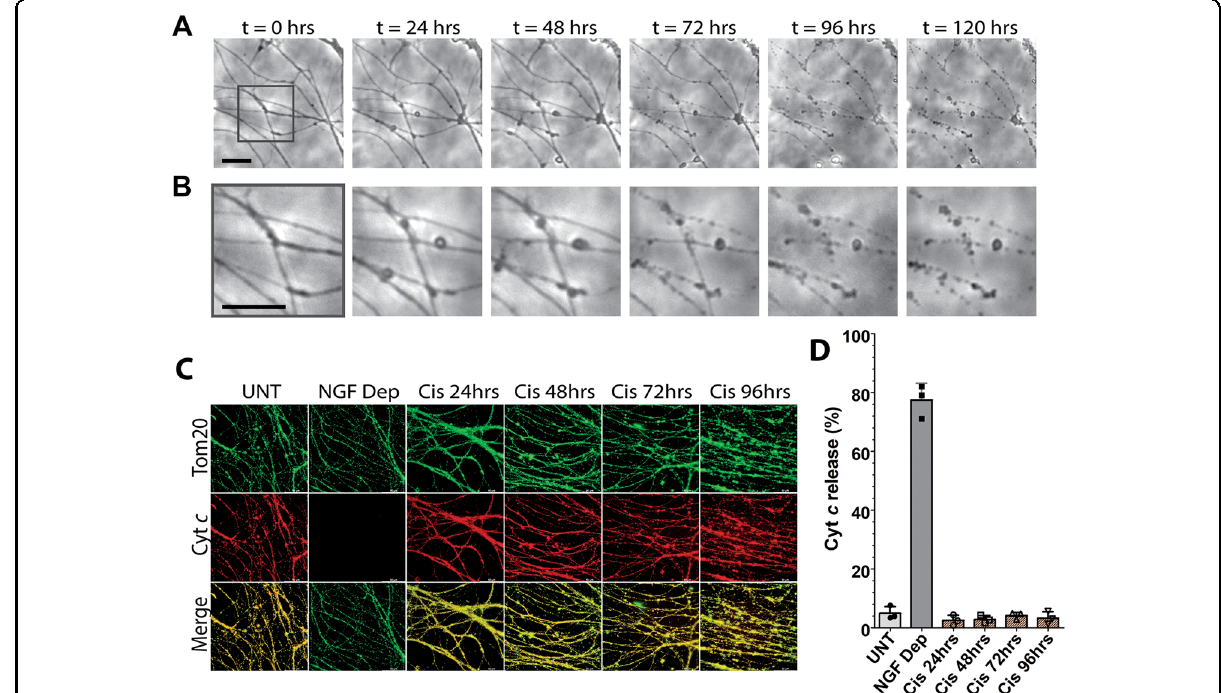
Fig. 3 Axonal mtDNA damage induces complete axon degeneration after 96 h of cisplatin exposure without the release of cyt c . Neurons were cultured in micro fl uidic chambers and had only their axons exposed to cisplatin (20 μ M) at t = 0 h and were monitored for degeneration by microscopy every 24 h for 120 h total. A Depicted in the top row are phase contrast representative images of axons in chambers illustrating how the same axons degenerate over 120 h, B Zoomed-in region from A that demonstrates the fi ner signs of damage that precede complete degeneration. The black scale bar for both rows is 20 μ m. C Immunostaining of cyt c and TOM20 (mitochondrial marker) to assess release of cyt c from axonal mitochondria treated with cisplatin. NGF deprivation of neurons for 48 h (in the presence of QVD-OPH) is included as a positive control for cyt c release. The quanti fi cation of cyt c release is shown in D , individual data points and mean are